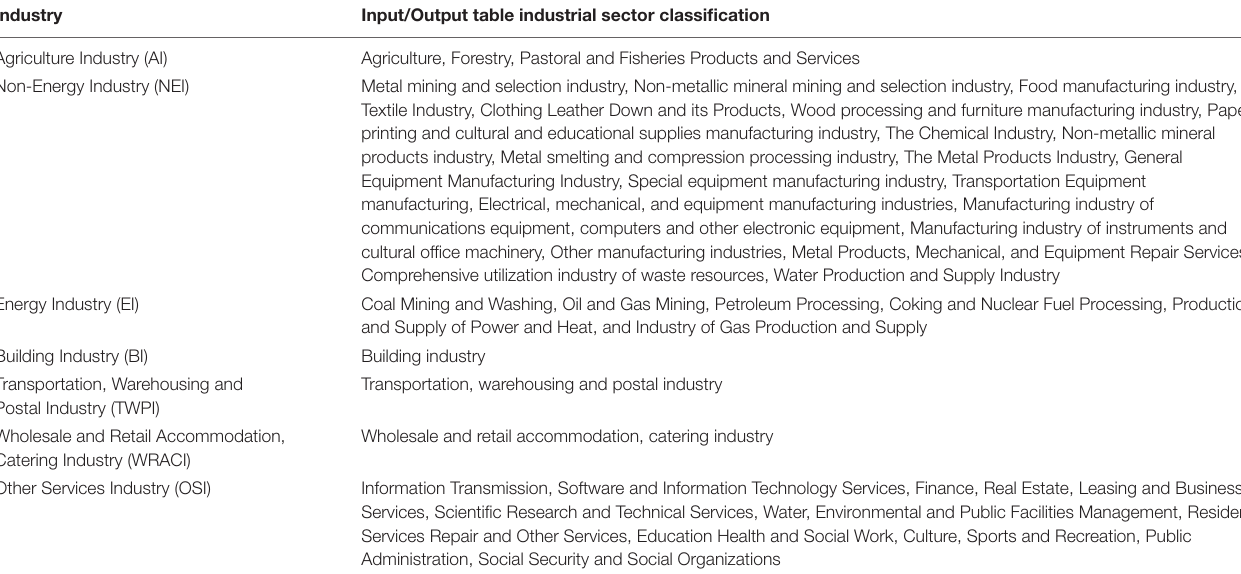
TABLE 1 | Industrial classification. Industry Input/Output table industrial sector classification